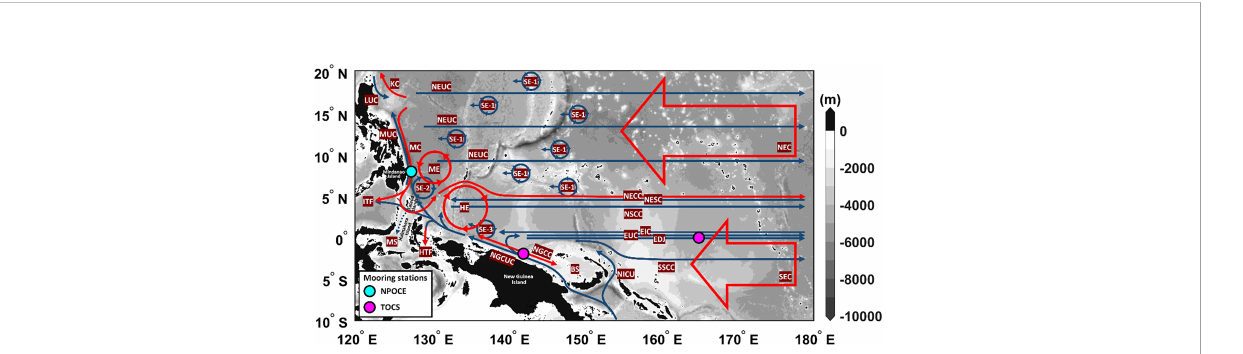
FIGURE 1 General pattern of the surface (red arrows) and subsurface (blue arrows) currents and eddies in the tropical western Paci fi c. The surface currents and eddies are the NEC (North Equatorial Current), the KC (Kuroshio Current), the MC (Mindanao Current), the NECC (North Equatorial Countercurrent), the SEC (South Equatorial Current), the NGCC (New Guinea Coastal Current), the ITF (Indonesian Through fl ow), HTF (Halmahera Through fl ow), the HE (Halmahera Eddy), and the ME (Mindanao Eddy). The subsurface currents and eddies are the NEUC (North Equatorial Undercurrent), the LUC (Luzon Undercurrent), the MUC (Mindanao Undercurrent), the NESC (North Equatorial Subsurface Current), the NSCC (North Subsurface Countercurrent), the EUC (Equatorial Undercurrent), EIC (Equatorial Intermediate Current), EDJ (Equatorial Deep Jets), the NGCUC (New Guinea Coastal Undercurrent), the NICU (New Ireland Coastal Undercurrent), the SE-1 (westward-propagating Subthermocline Eddy), the SE-2 (anticyclonic Subthermocline Eddy southeast of Mindanao Island), and the SE-3 (northwestward-propagating Subthermocline Eddy). The colored circles indicate the ADCPs mooring stations. The color shading indicates bathymetry